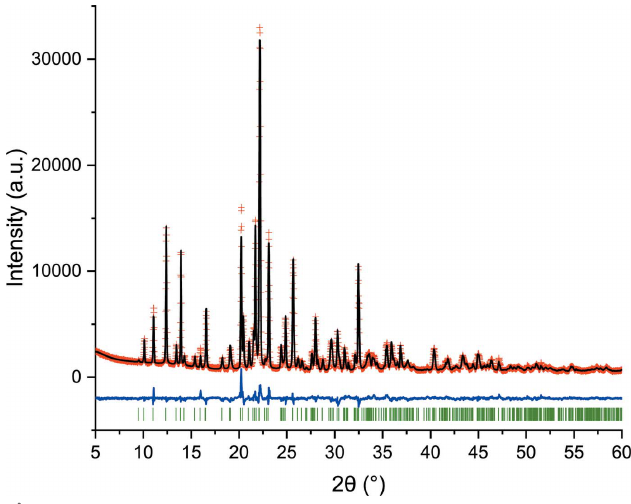
Figure 7 Rietveld plot obtained after the structure refinement of RS